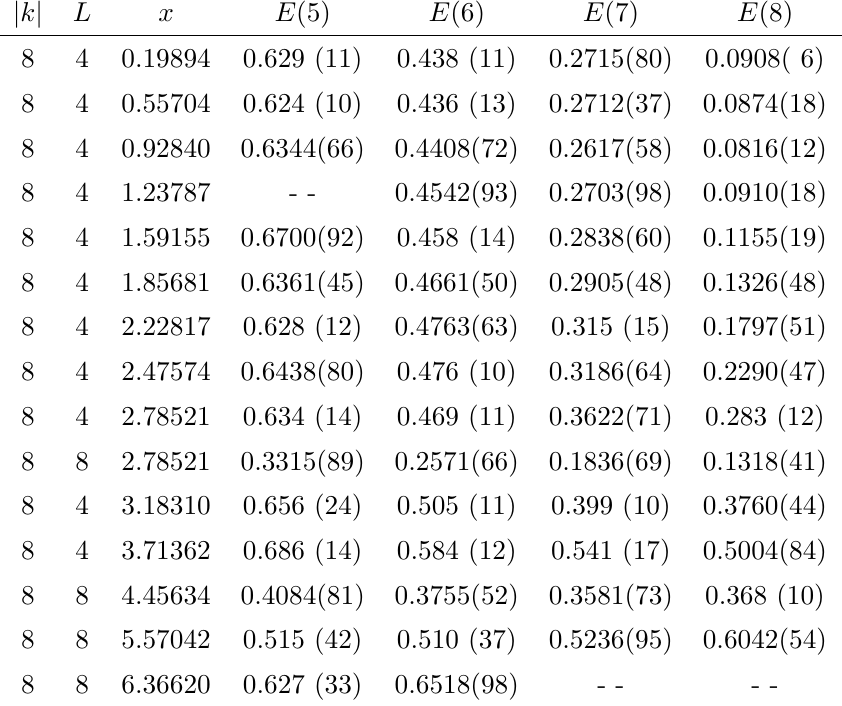
Table 16. SU(17) torelon energies (in lattice units) (continued).